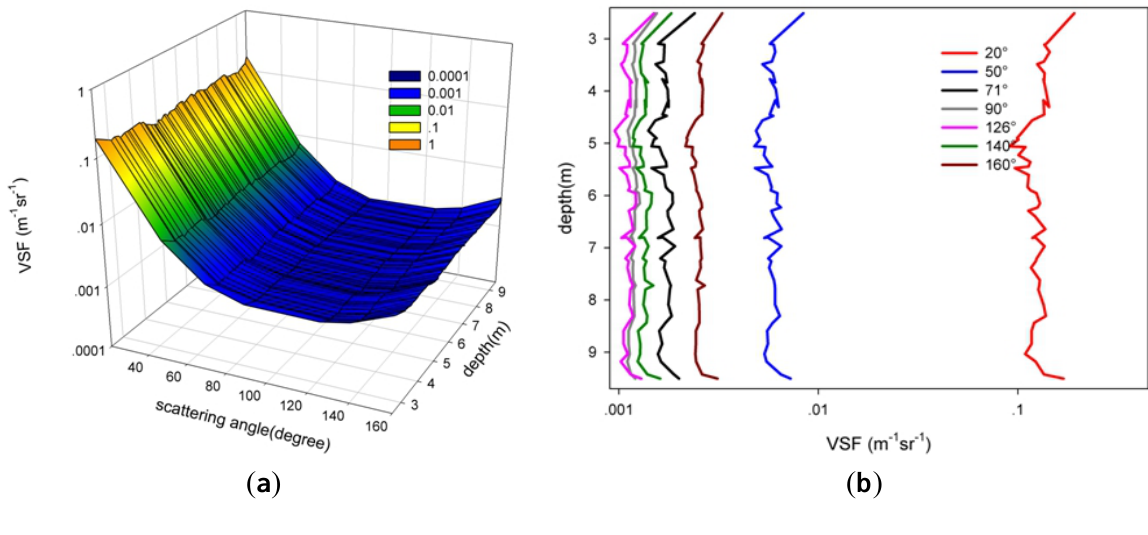
Figure 12. The distribution of the profile and the angle of the VSF (station B, 22°58 ′ N, 114°54 ′ E). ( a ) shows the three-dimensional distribution of the VSF with profile and angle; ( b ) shows the distribution characteristics of the VSF with profile at different